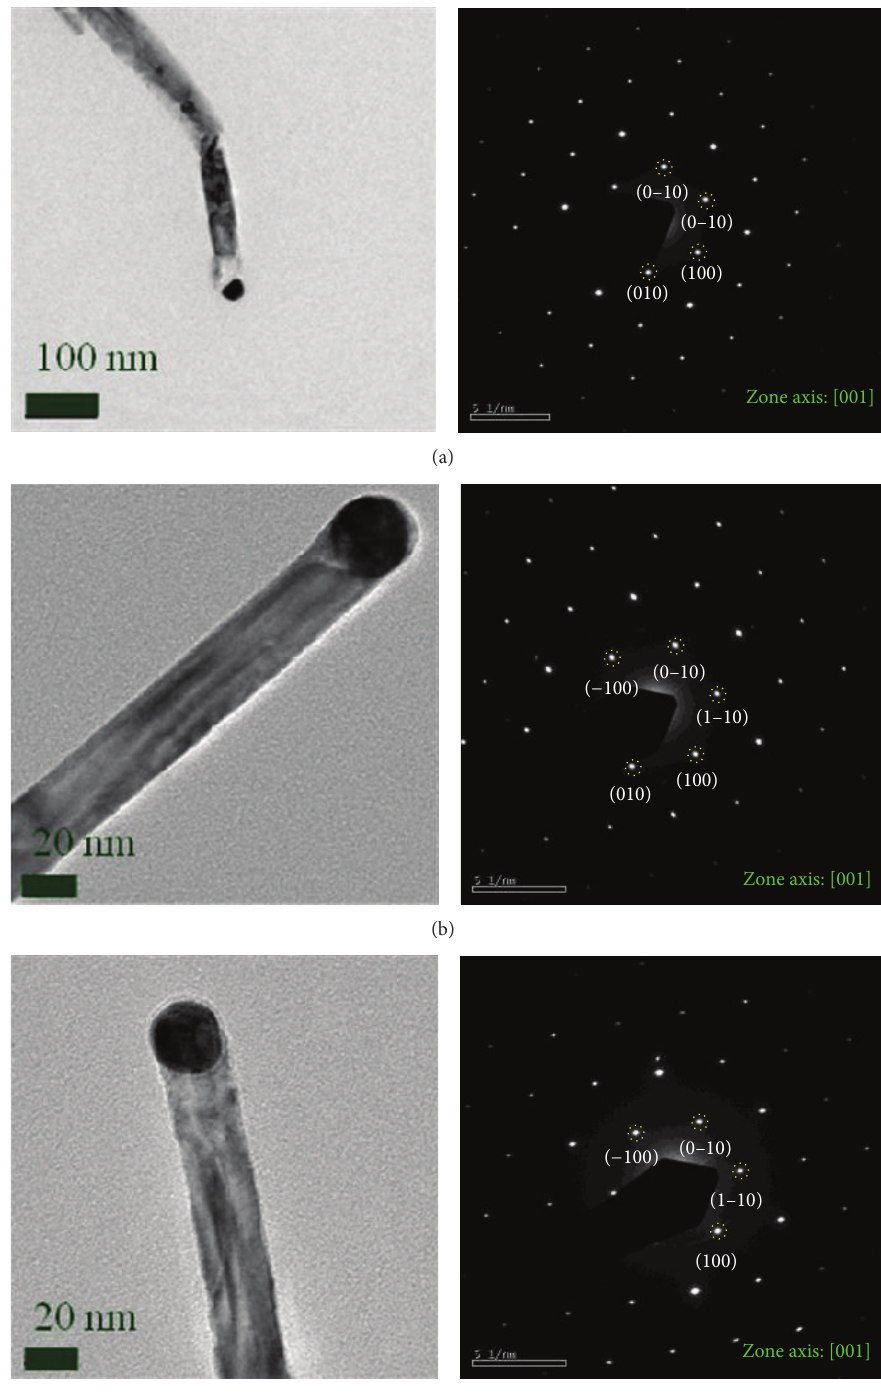
Figure 3: TEM images and the corresponding SAED patterns of ZnO:In NWs with different indium concentrations (a) undoped, (b) 0.86%, and (c)